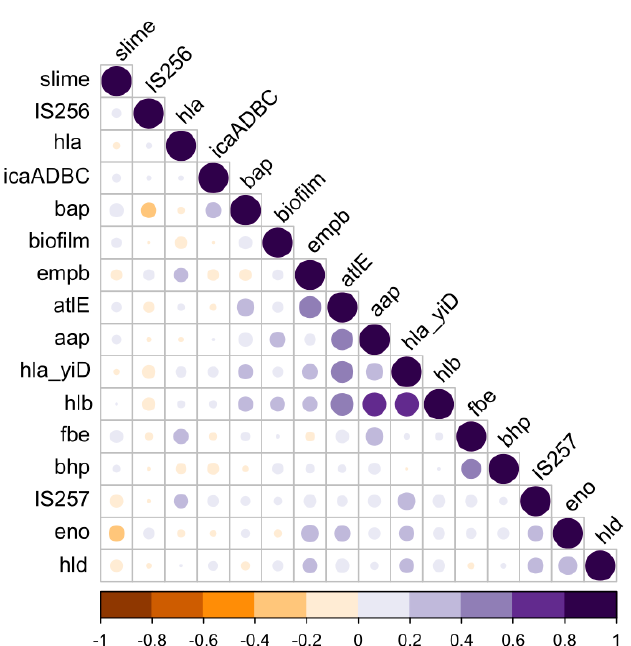
Figure 1. Correlation matrix indicating all correlations between the pairs of genetic or phenotypic determinants (biofilm and slime phenotypes). Shades of purple represent the positive correlations, while shades of orange represent the negative correlations.